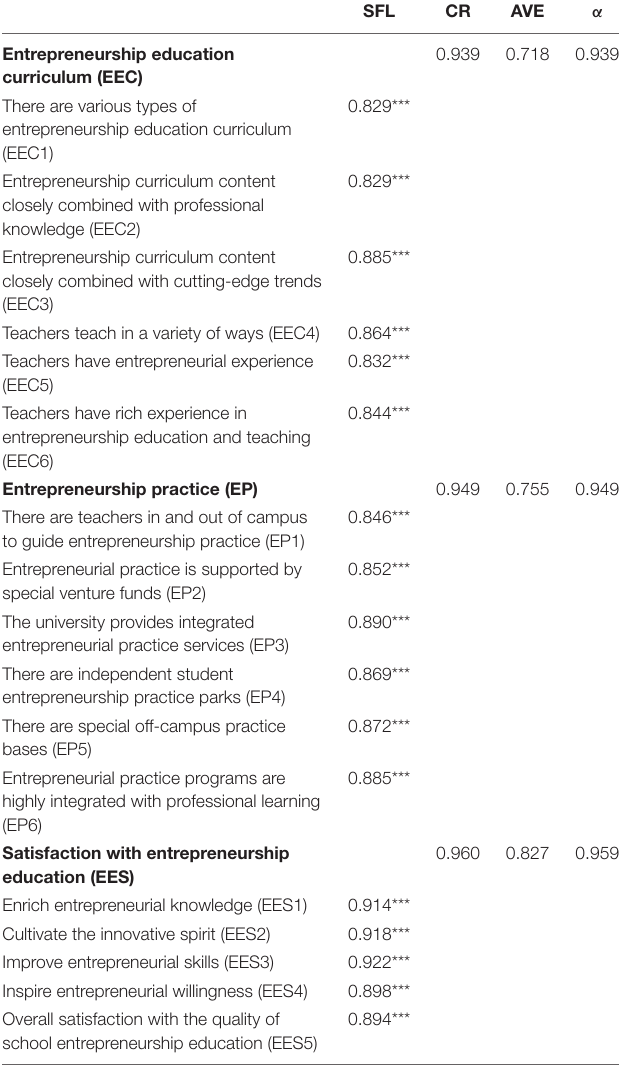
TABLE 5 | The reliability and validation of the study model ( N = 1223).